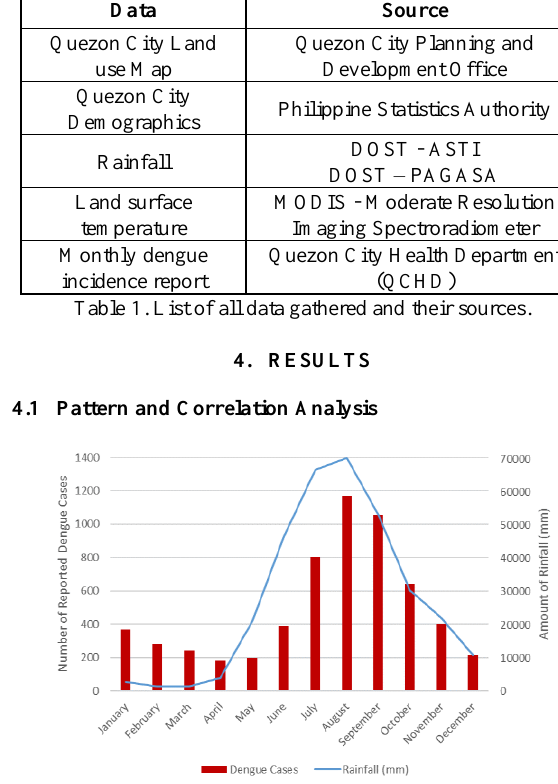
Figure 2. Quezon City’s average monthly reported dengue